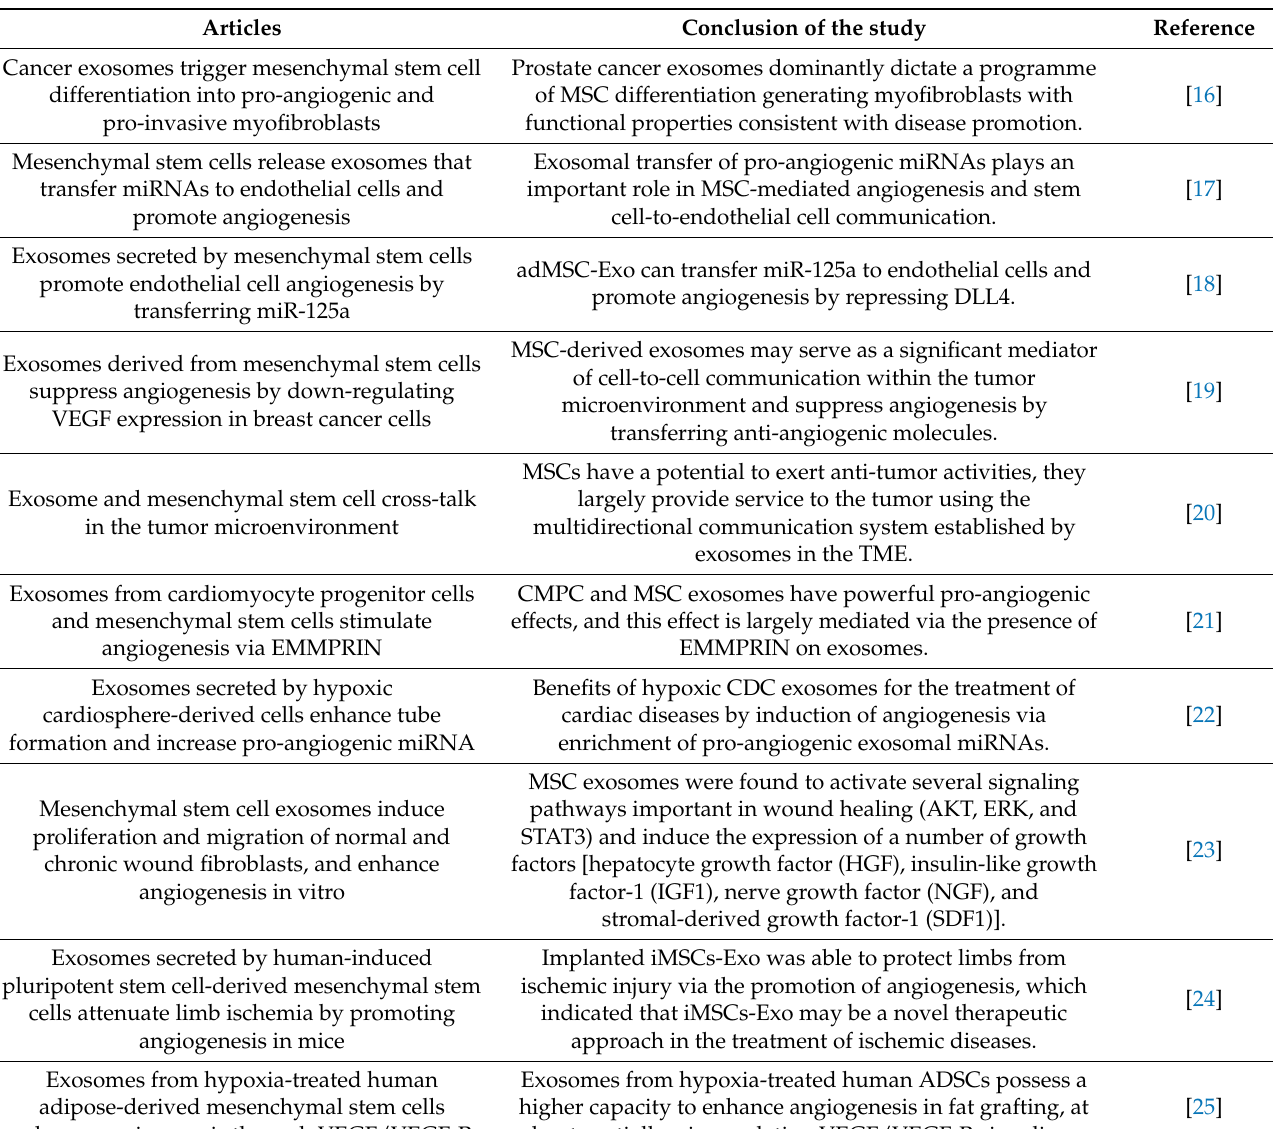
Table 4. Studies showing pro-angiogenic role of mesenchymal stem cells-derived